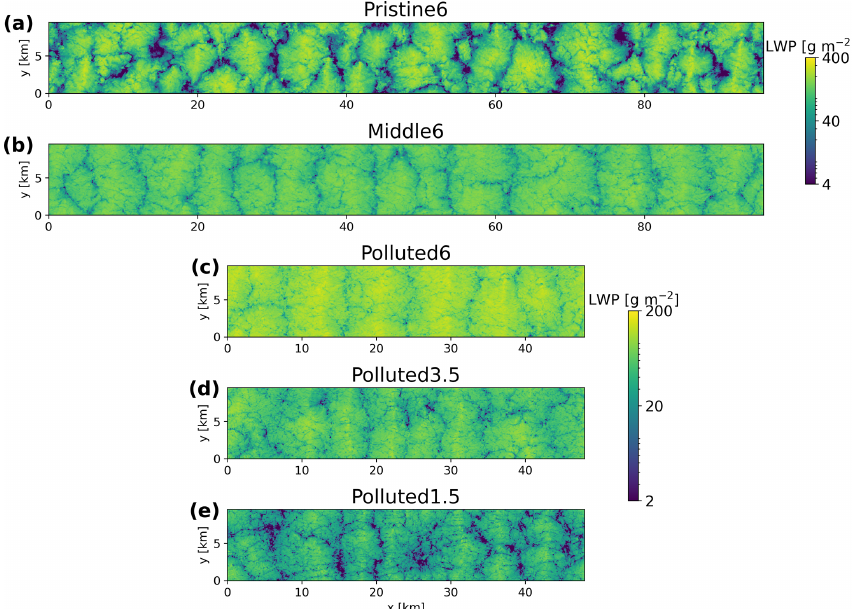
Figure 2. As in Fig. 1 but for nighttime (00:08LT).